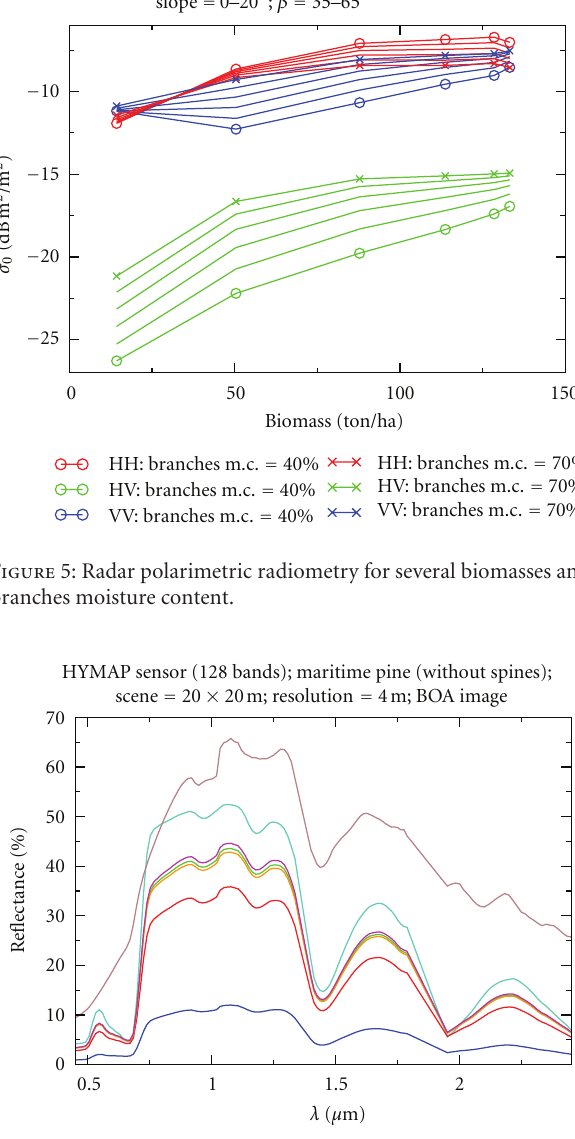
in branches weight, and then the part of soil in the images decreases.